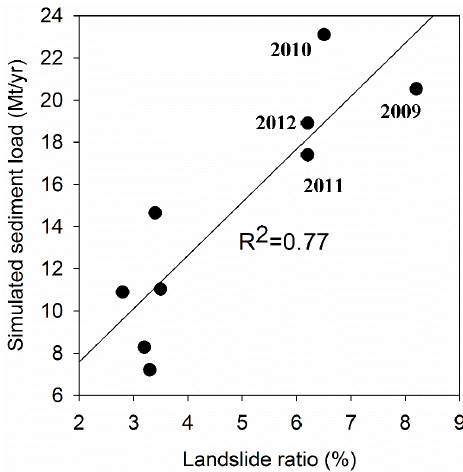
Figure 13. Relationship between SWAT simulated annual L s and landslide ratio of GRB during 2004–2012 ( p = 0.002). Note that the L s during the period of 2004–2009 and 2010–2012, simulated by the NSCE and log-RMSE calibrated